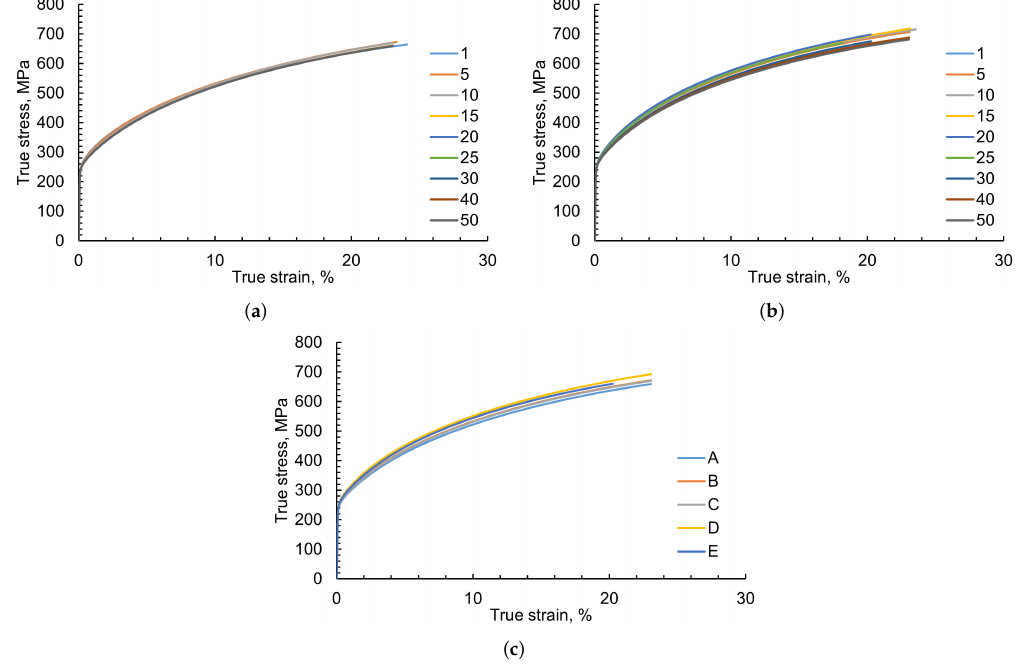
Figure 3. Comparison of global stress–strain curves of different cases ( a ) RVE-A all layers’ comparison, ( b ) RVE-E all layers’ comparison, ( c ) showing true stress strain curves for RVEs with different grain sizes. It is observed that there is not much difference in the results and almost any geometry yields very similar results. Some numerical simulation models crashed due to the non convergence of global stress/strain equilibrium at the spectral code level, and therefore are presented up to that certain level of